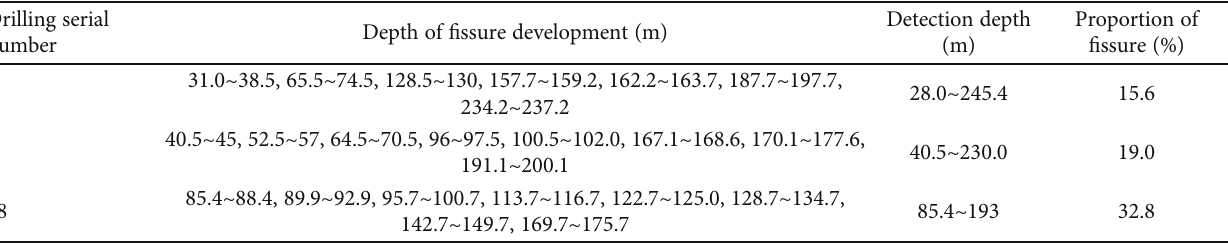
Figure 7: Displacement stress distribution diagram during strip grouting in the goaf. Table 2: Observation of the depth statistics of borehole fracture